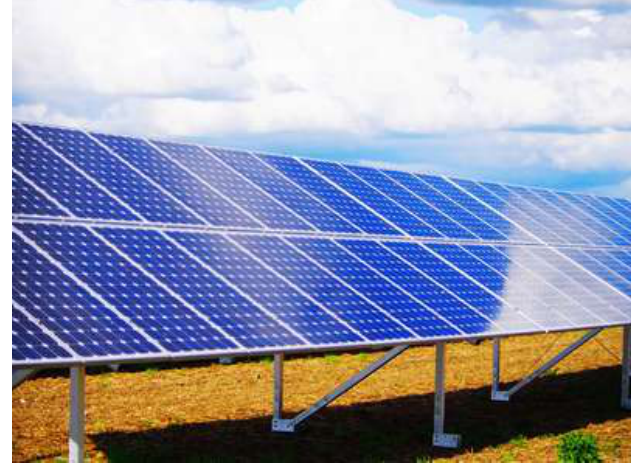
Figure 2. Solar Panels [46].